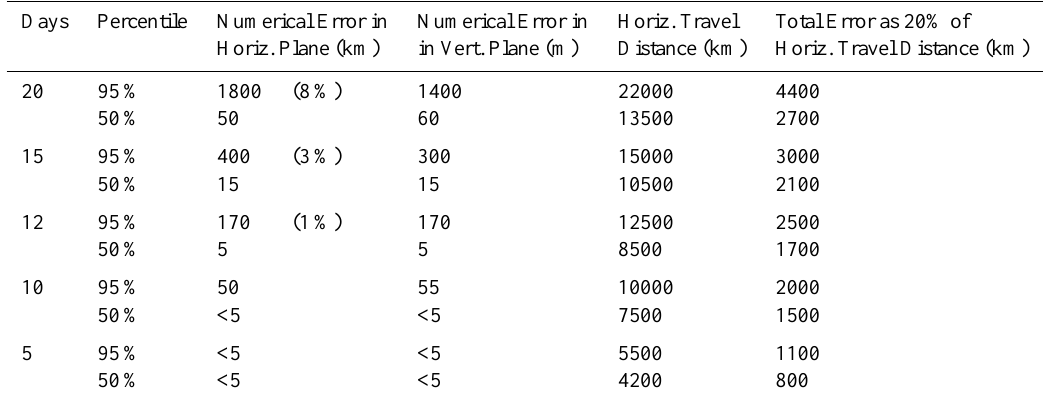
Table 2. The 95 and 50% percentiles of numerical (columns 3, 4) and total errors (column 6) from 6084 FT back trajectories for various trajectory timescales between 5 and 20 days. Relative numerical errors are provided in parentheses where these are equal or higher than 1% of the total trajectory travel distance (column